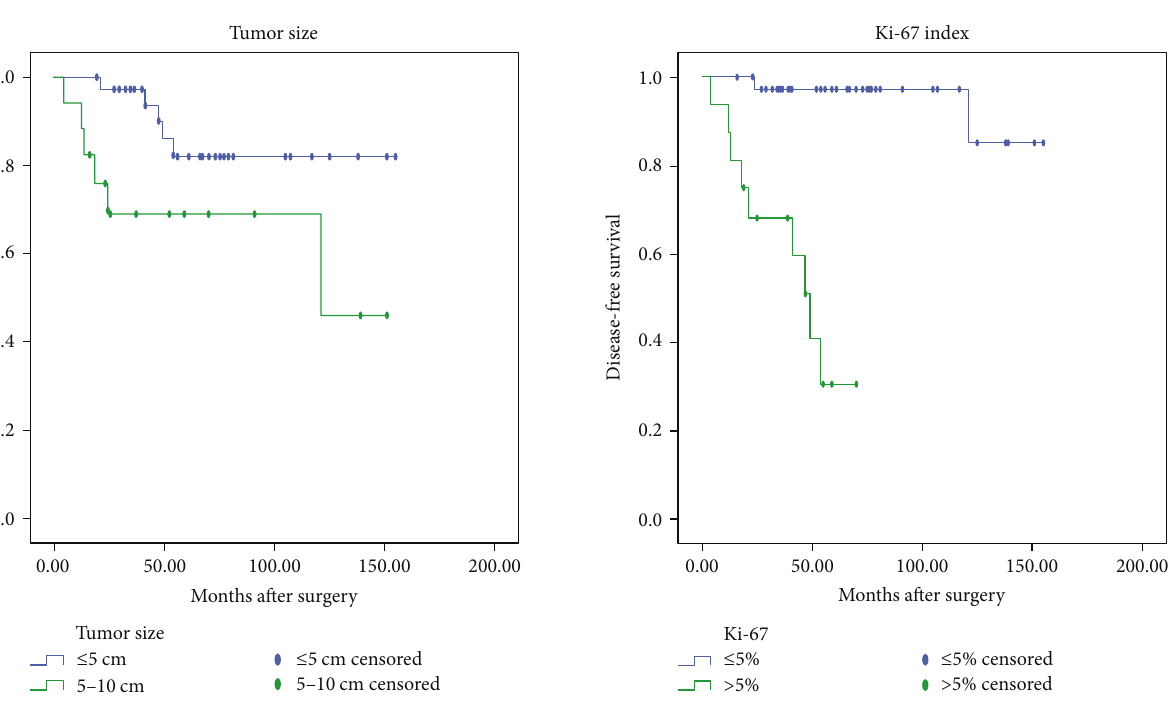
Figure 1: The Kaplan-Meier survival analysis of tumor size > 5 cm predicts a poorer prognosis of duodenal stromal tumor.